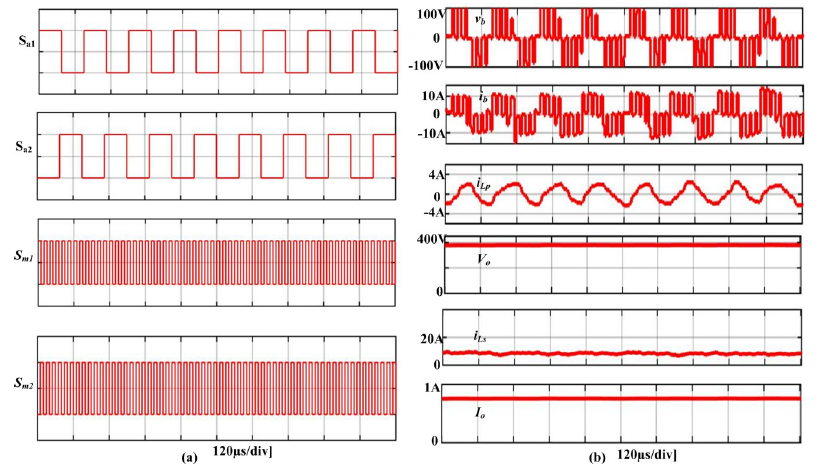
Fig 9. Simulation results of the developed FB cascaded CW converter.